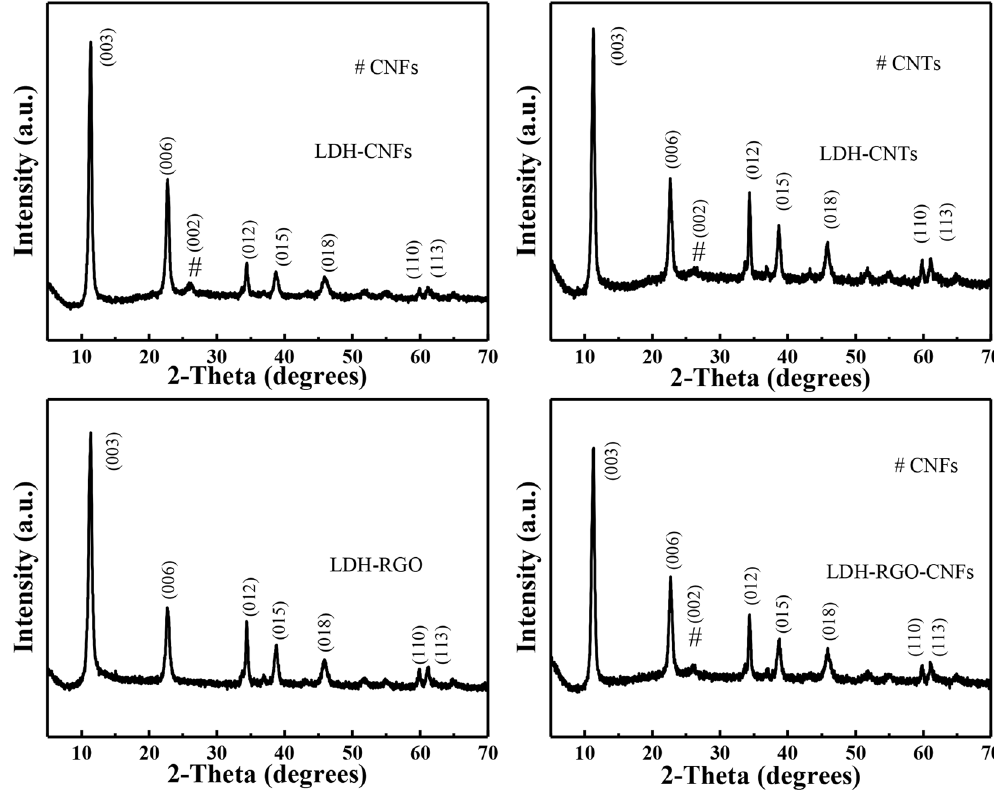
Figure 1. XRD spectra of LDH-CNFs, LDH-CNTs, LDH-RGO and